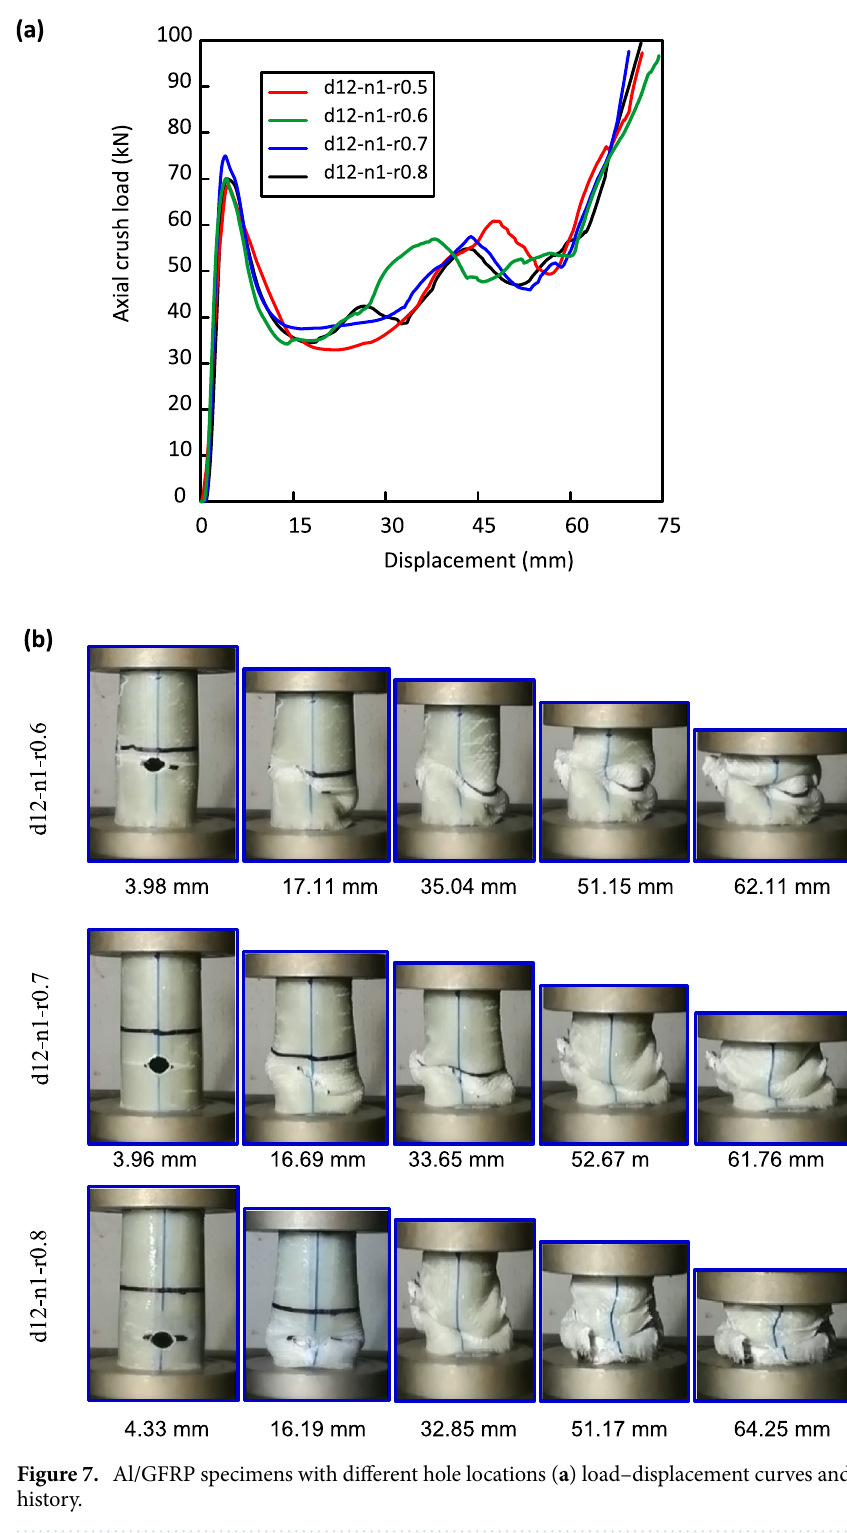
Figure 7. Al/GFRP specimens with different hole locations ( a ) load–displacement curves and ( b ) crushing consequently decreases the specimen stiffness 68 . Later F ip sharply dropped accompanied with oscillations which reflects the unstable behavior of the pipes (Fig. 7a). Cracks around the holes accompanied with buckling and wrinkling of the specimens’ wall were recorded (Fig. 7b). Compared with A0 specimen, F ip of d12-n1-r0.6, d12-n1-r0.7 and d12-n1-r0.8 specimens decreases by 10.05, 3.74, and 10.11%, respectively. Max CFE with a value of 0.67 was detected for d12-n1-r0.6 specimen against a value of 0.66 for d12-n1-r0.5 specimen. It can be concluded that (L/H) of the cut-out has no weighty effect on